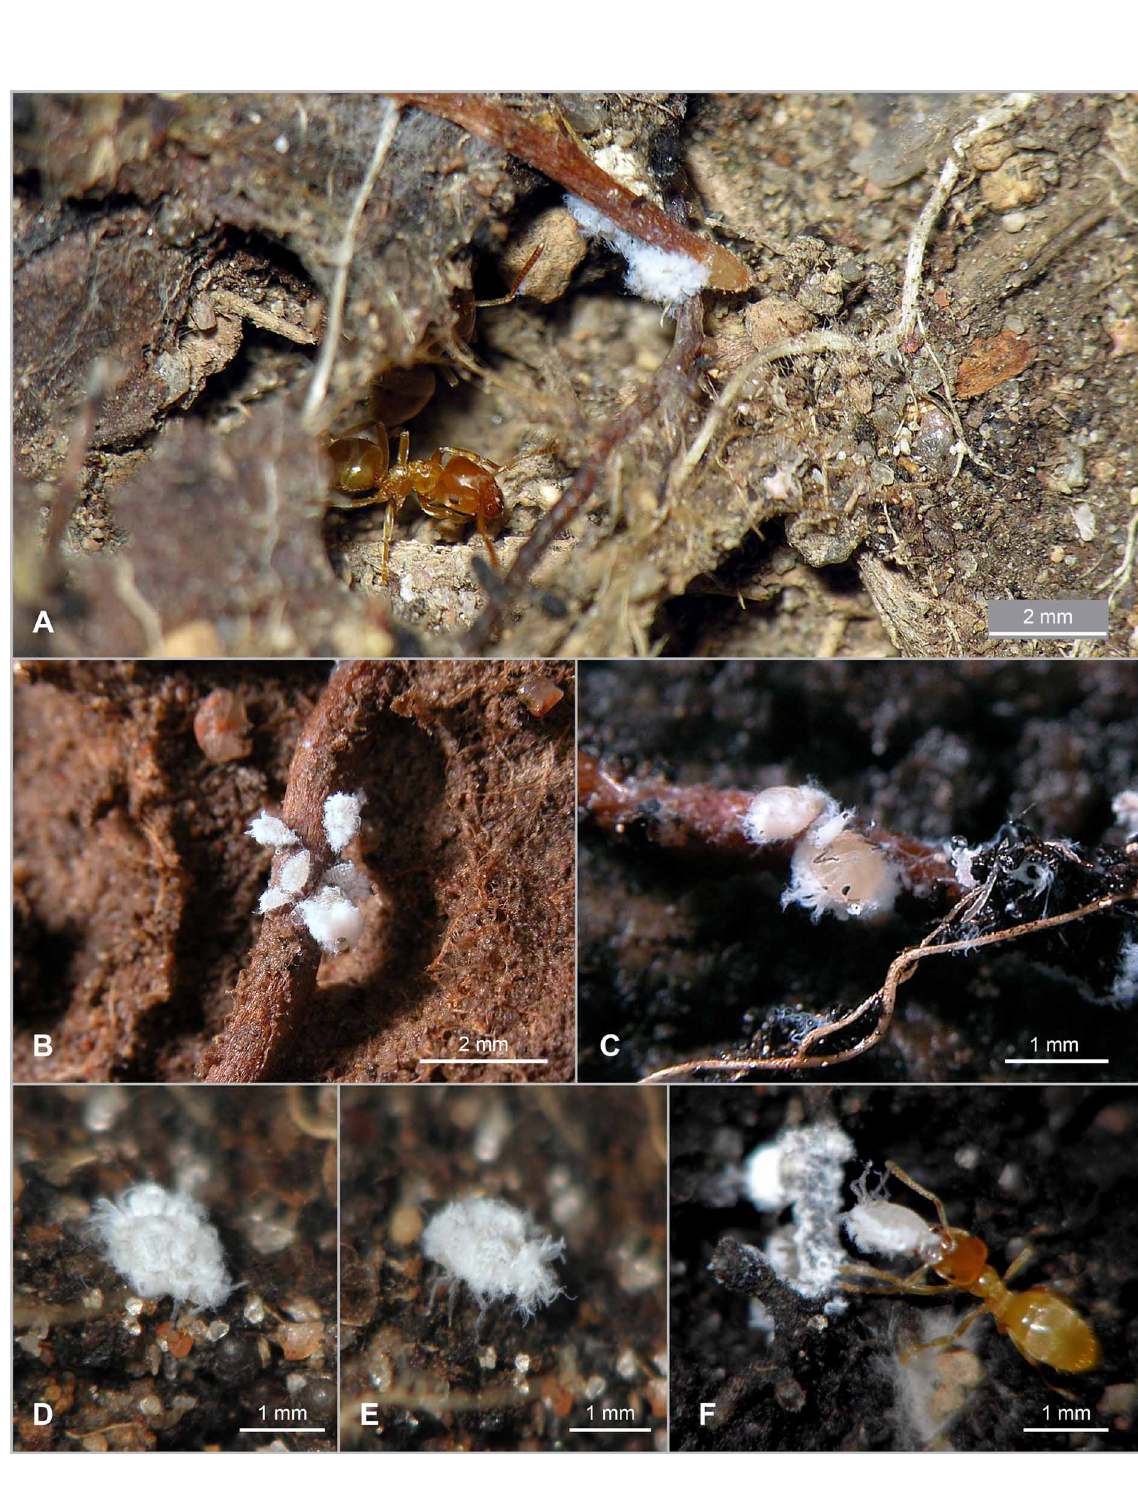
Fig. 110. Prociphilus (Stagona) pini (Burmeister, 1835). Apterae and juveniles on mycorrhizal roots of Pinus sylvestris in galleries of Lasius flavus (Fabricius,